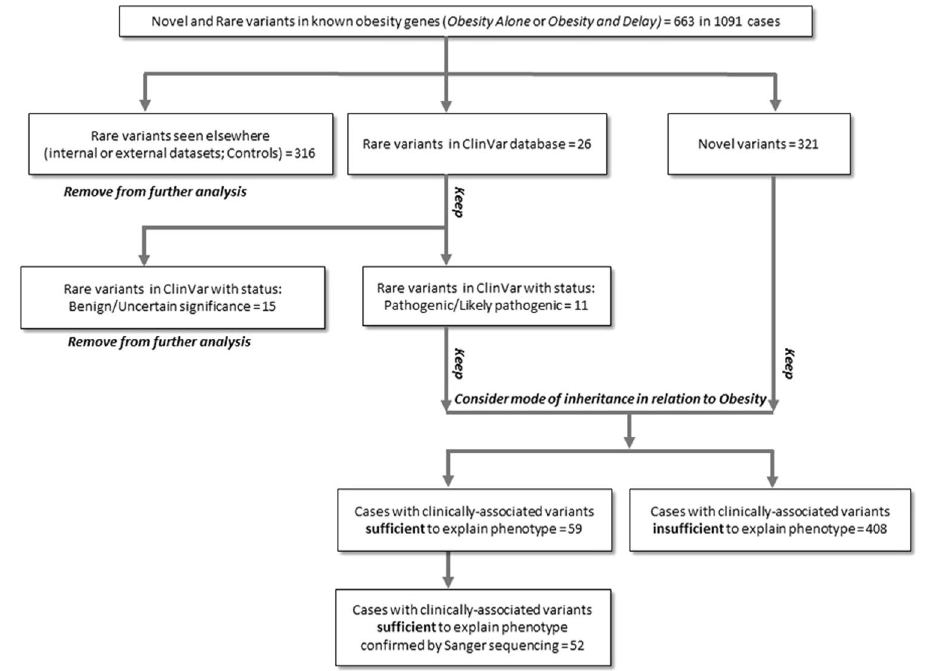
Figure 1. Identification of clinically-associated variants in known human obesity genes. Schematic outlining the analysis